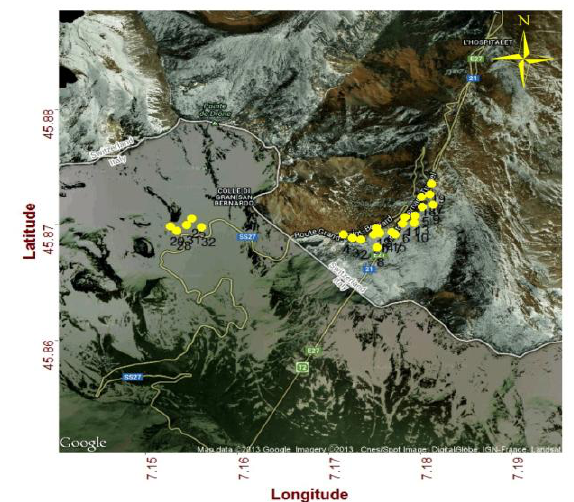
Figure 1. The Grand-St.-Bernard WSN deployment in geographic coordinate